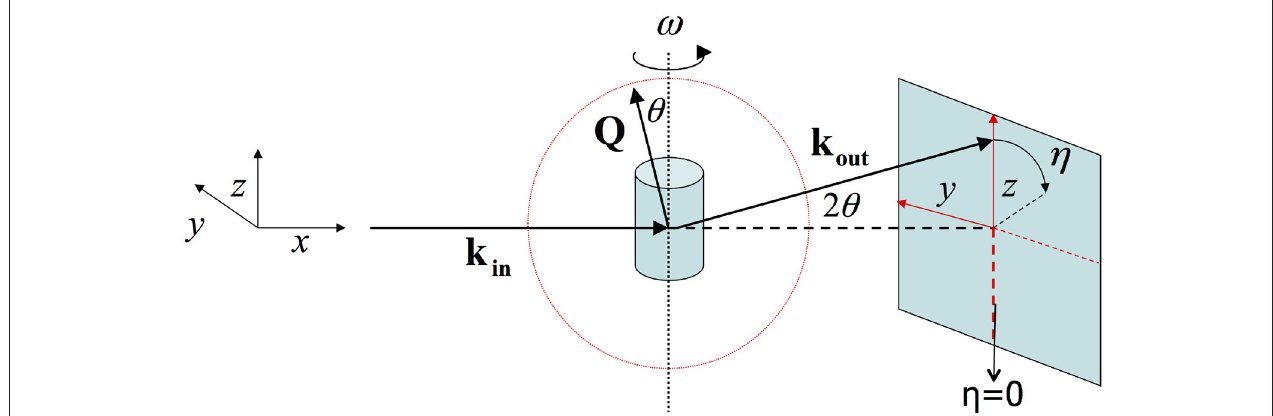
FIGURE 1 | In the geometry of 2D X-ray diffraction the X-ray beam lies along the x-axis. ω reflects the angle with which the sample is rotated along the z-axis. And η is the angle along the diffraction ring.